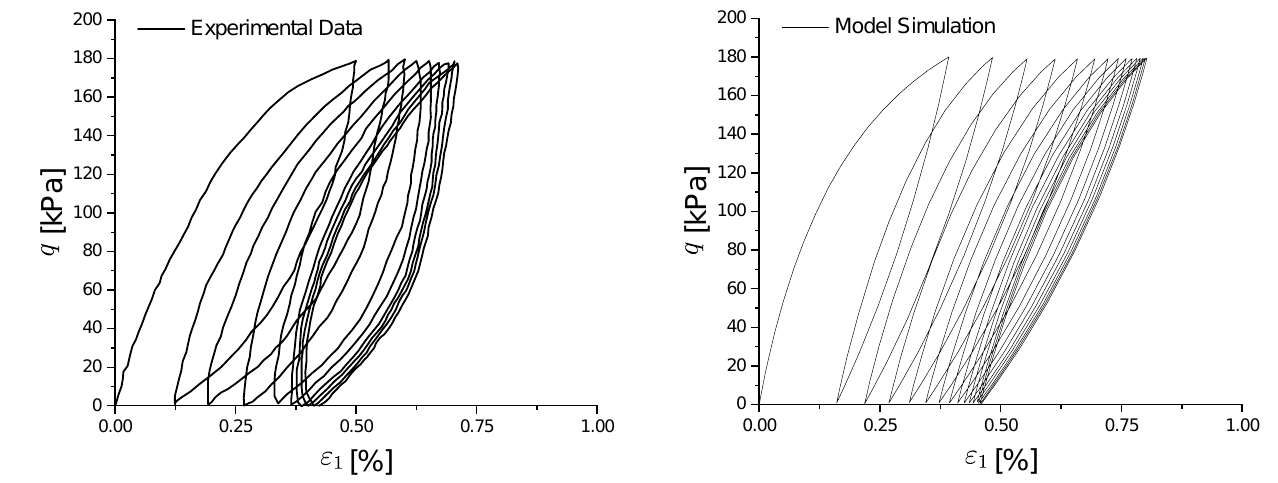
Figure 10. Experimental and numerical comparison of Newfield clay cyclic stress–strain